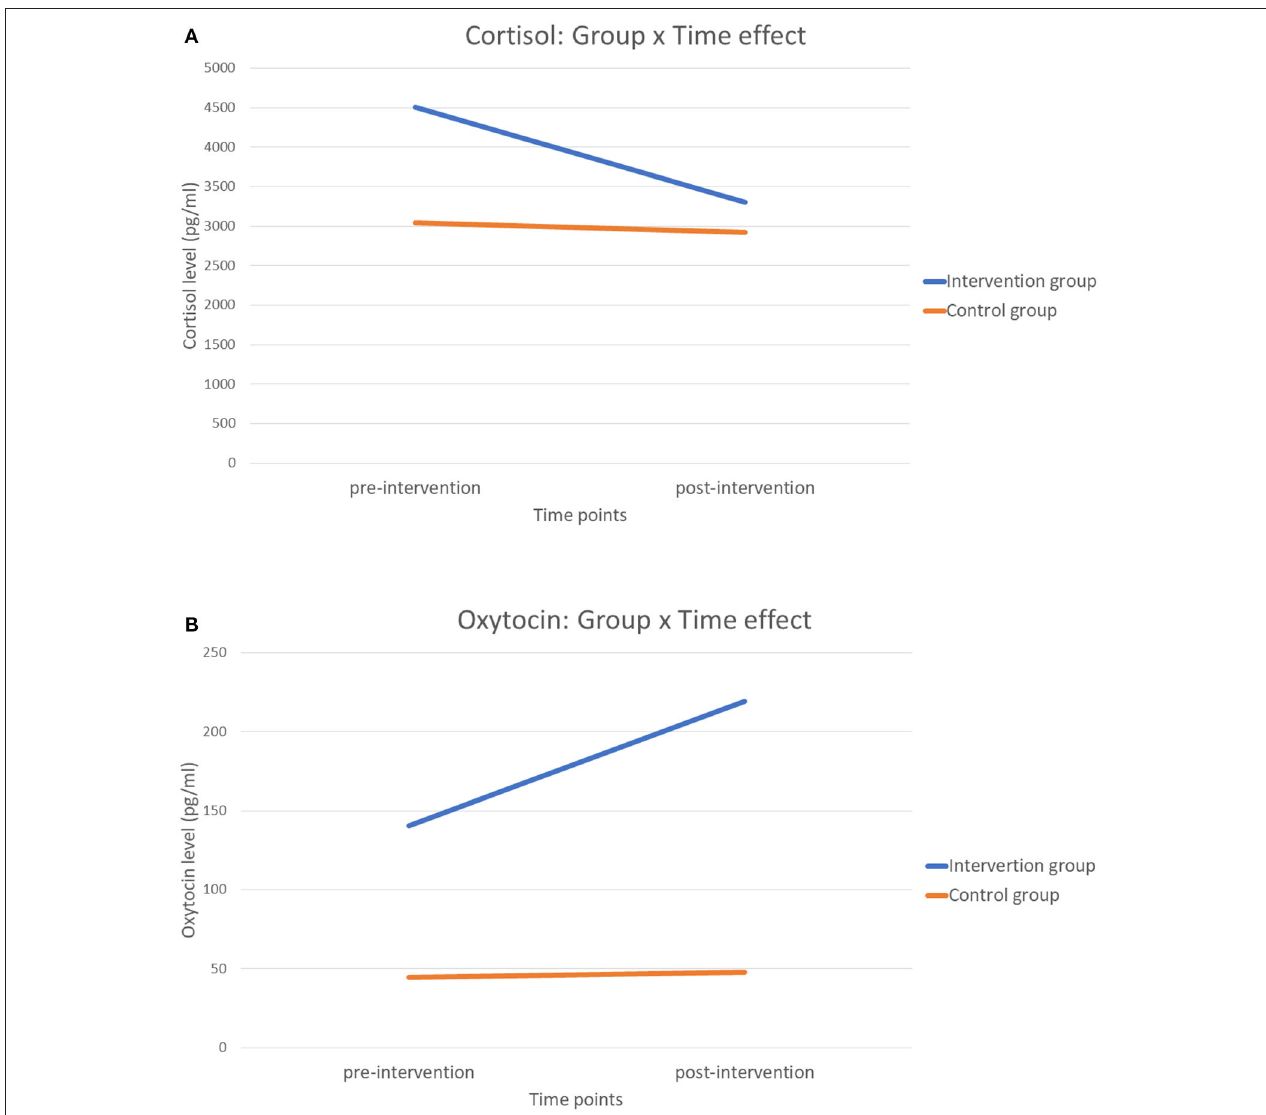
FIGURE 1 | (A) The group by time effect in cortisol levels. (B) The group by time effect in oxytocin